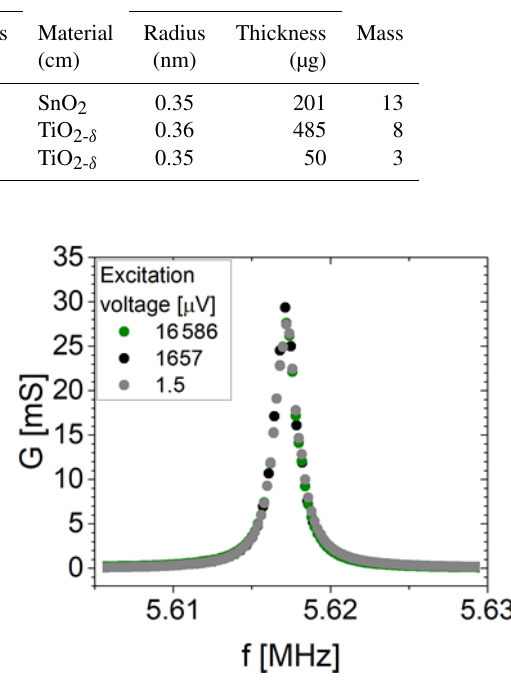
Figure 6. Conductance G of a ∼ 5 . 6MHz CTGS resonator in the vicinity of the resonance for different excitation